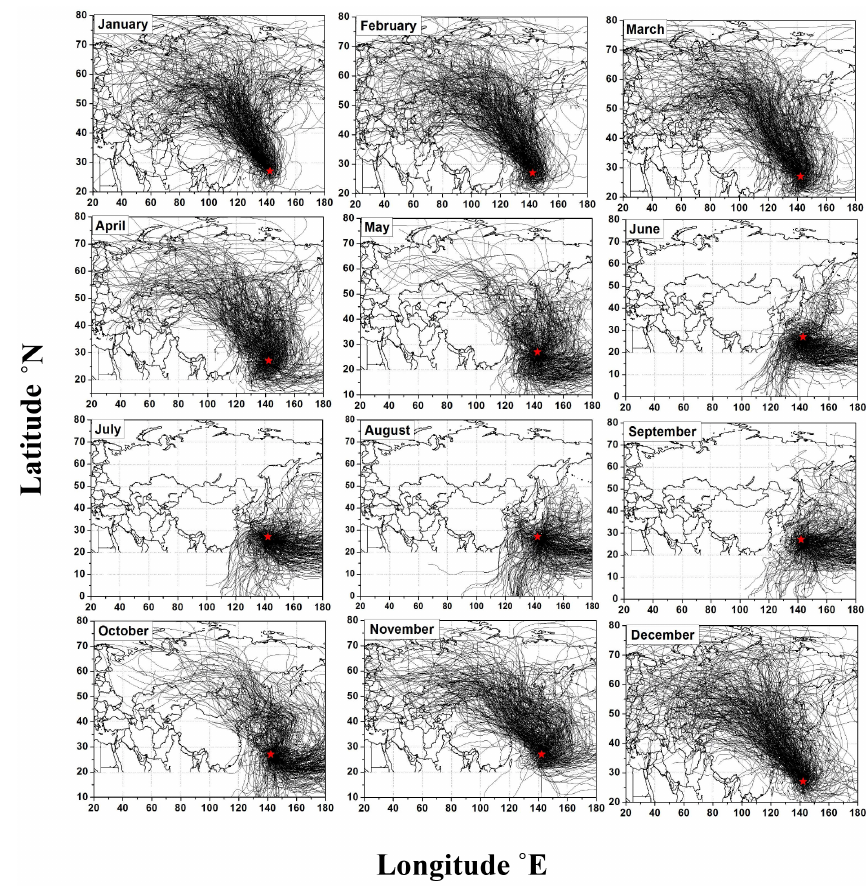
Figure 3. NOAA HYSPLIT 10-day backward air mass trajectories at 500ma.g.l. for each month over Chichijima Island during